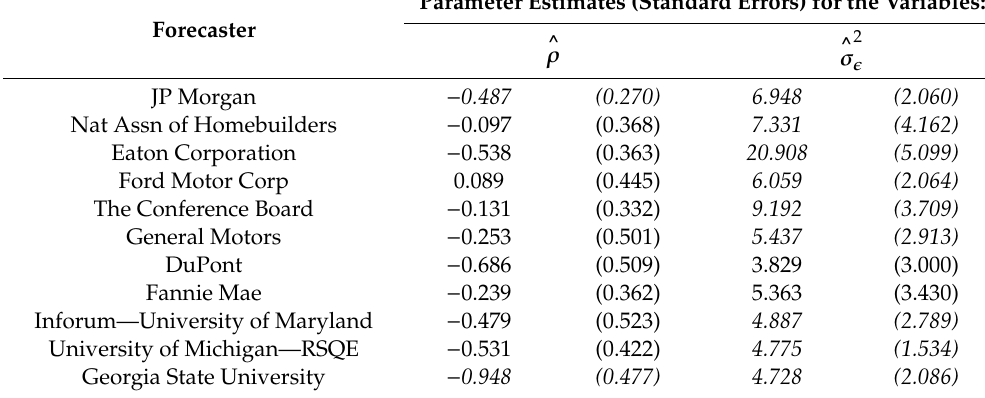
Table 1. Estimation results for (1) for forecasting real GDP growth, USA, 1996–2018. Italics means significant at the 10% level.